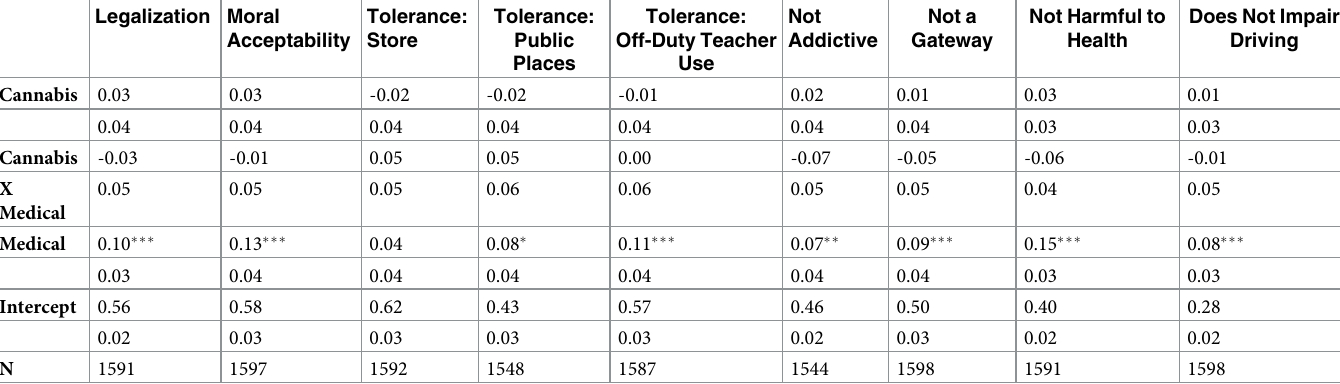
Baseline reference group is “Marijuana” condition. Table entry is OLS regression coefficient with standard error below. Survey weights applied. � p < 0.10 �� p < 0.05